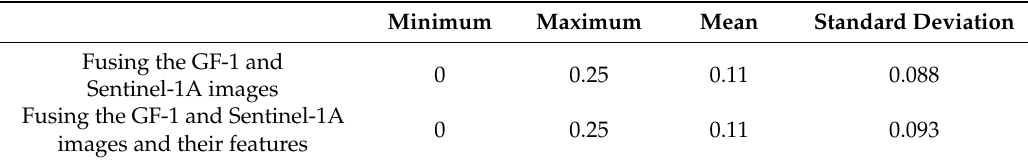
Table 6. The uncertainty statistics for impervious surfaces derived by fusing the GF-1 and Sentinel-1A images/the GF-1 and Sentinel-1A images and their features.